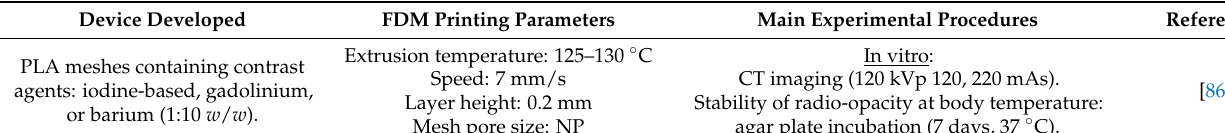
PLA meshes containing contrast agents: iodine-based, gadolinium, or barium (1:10 w / w ).